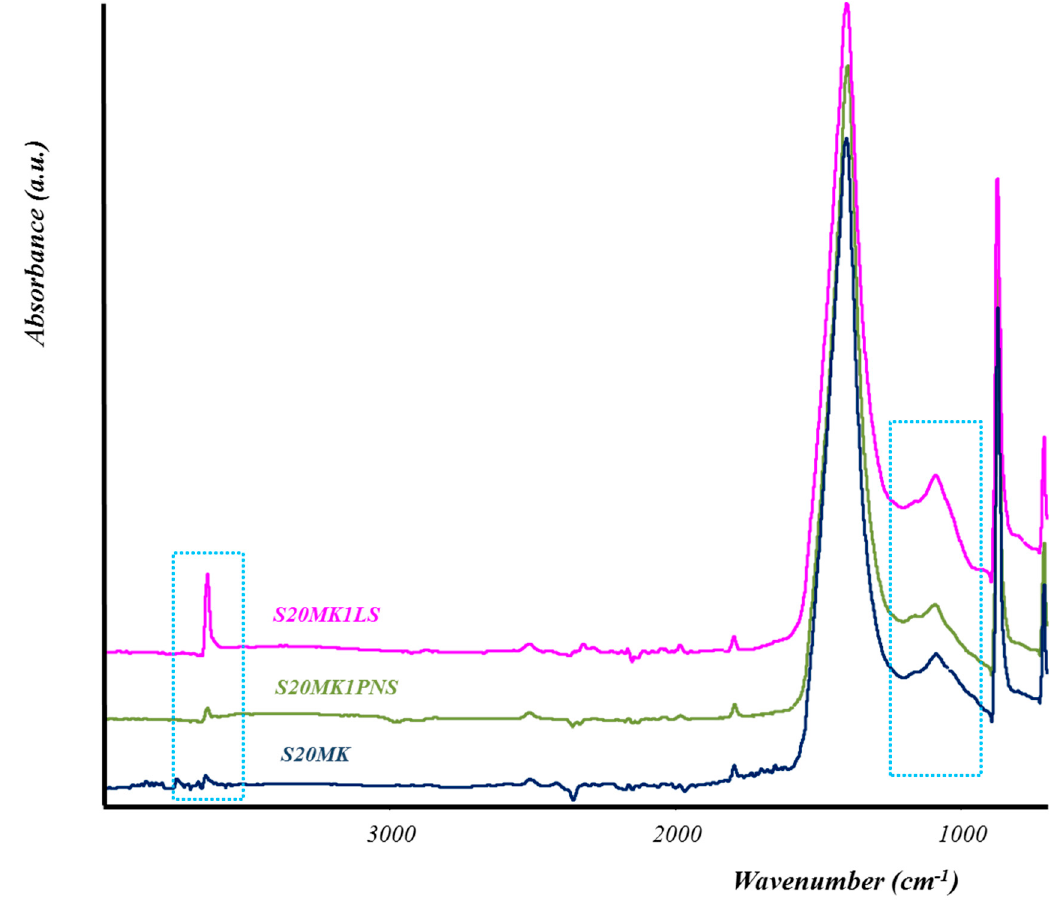
Figure 9. FTIR spectra of different samples after 91 curing days.